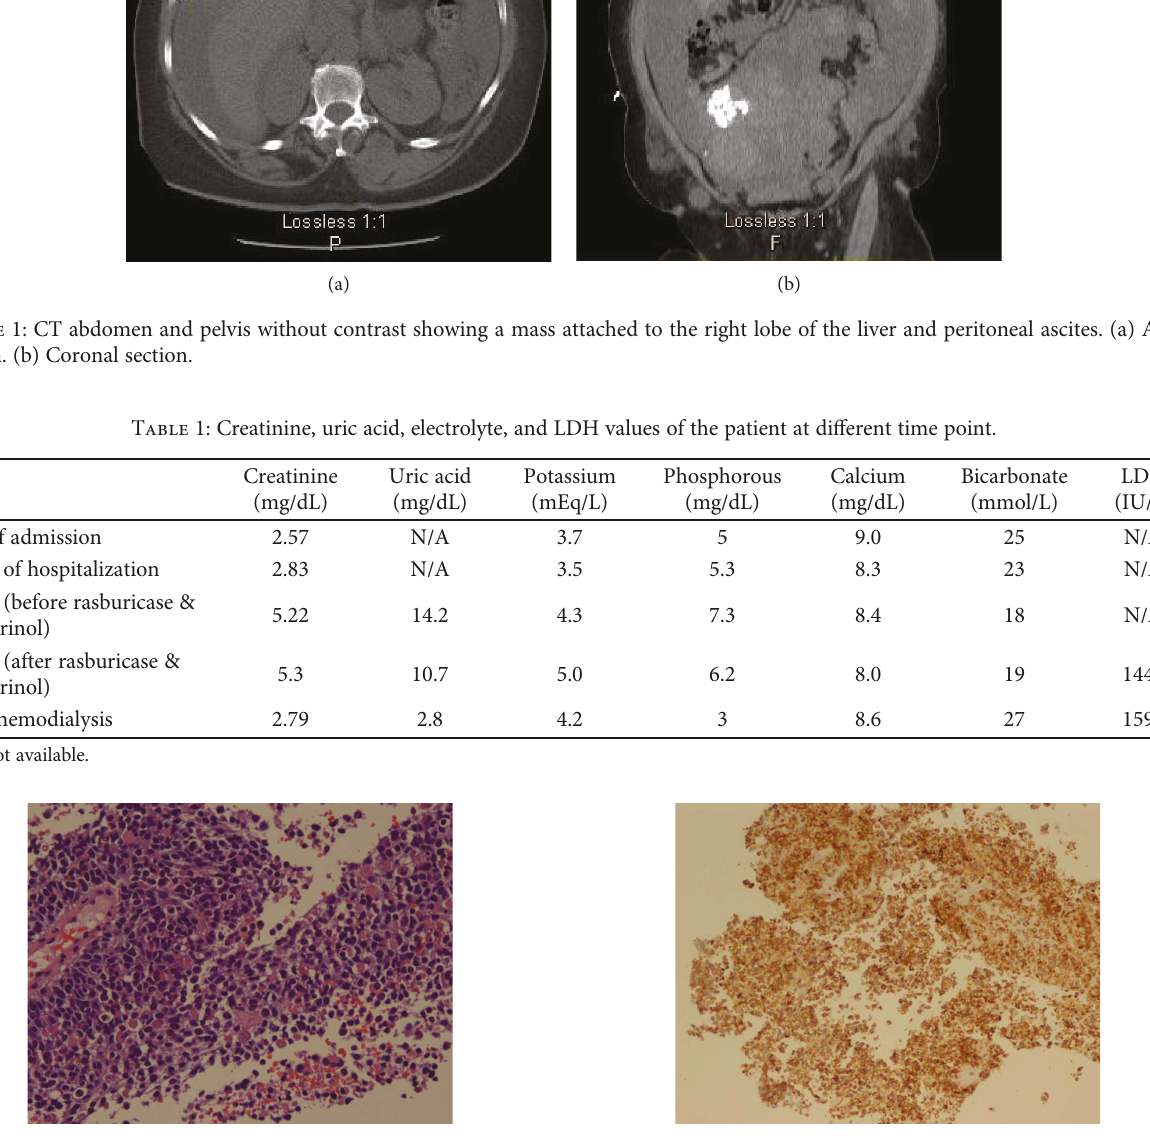
Figure 3: IHC (synaptophysin) stain of the tumor tissue showing positive synaptophysin con fi rming the tumor was neuroendocrine.